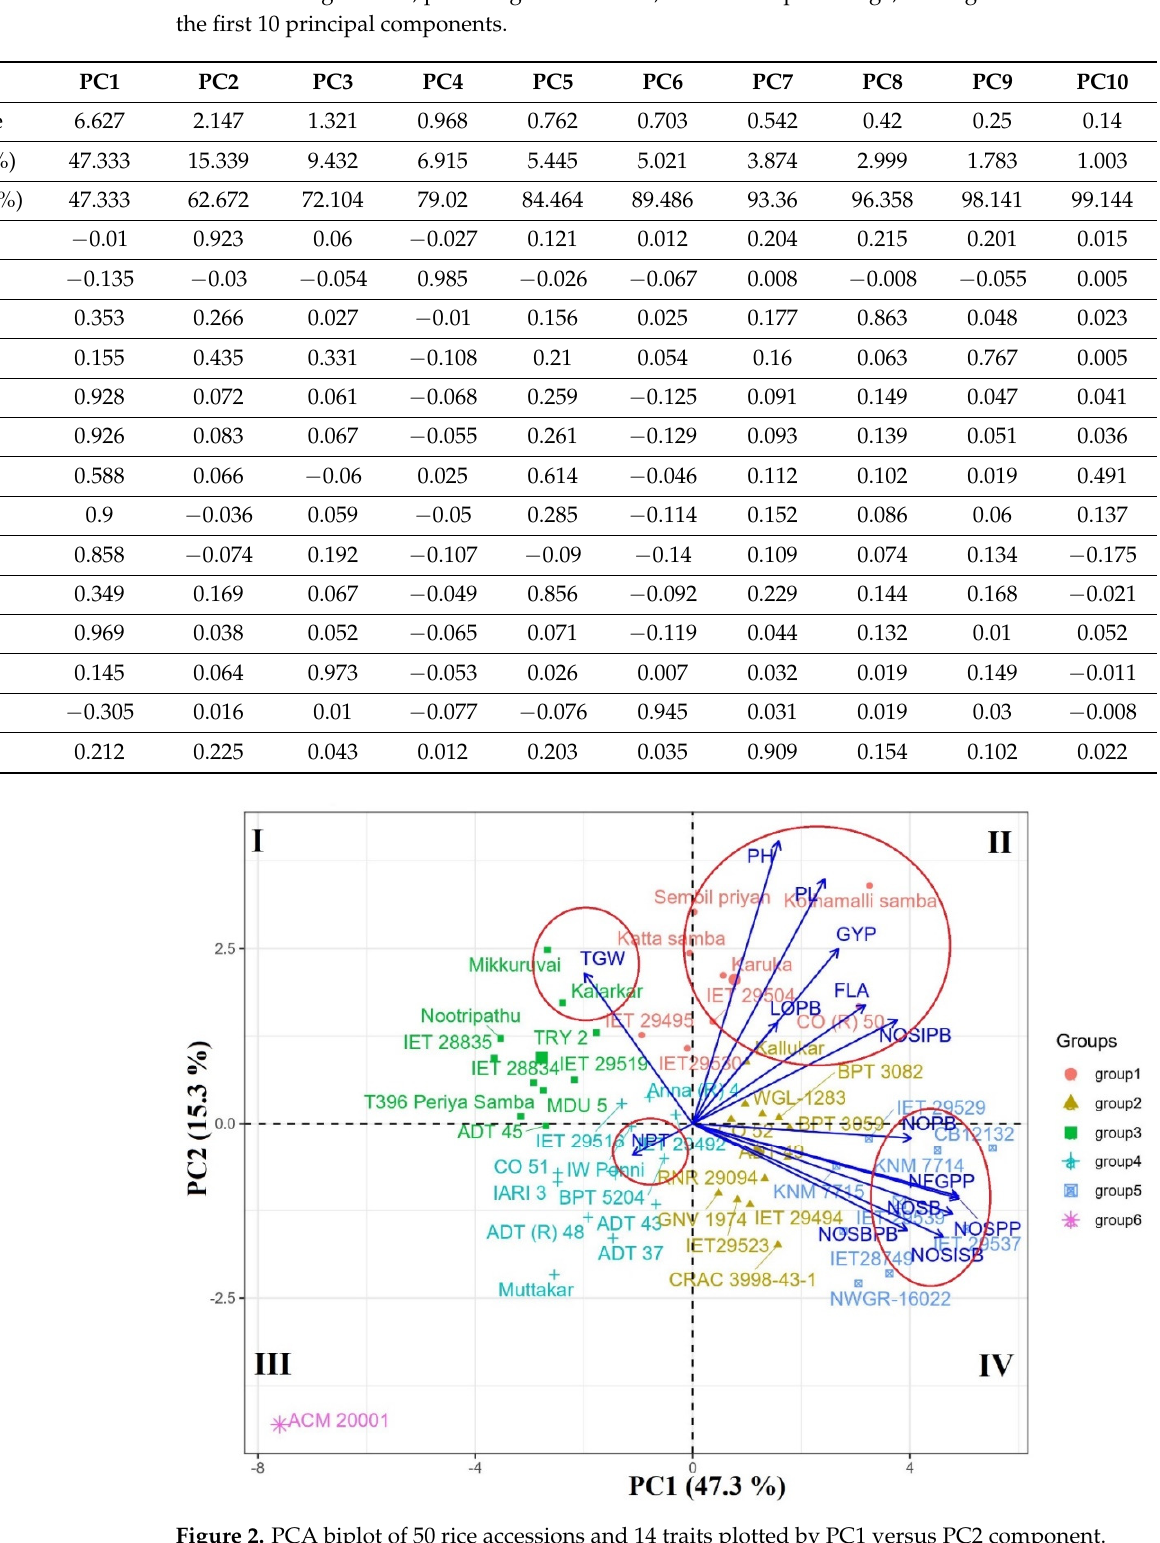
Figure 2. PCA biplot of 50 rice accessions and 14 traits plotted by PC1 versus PC2